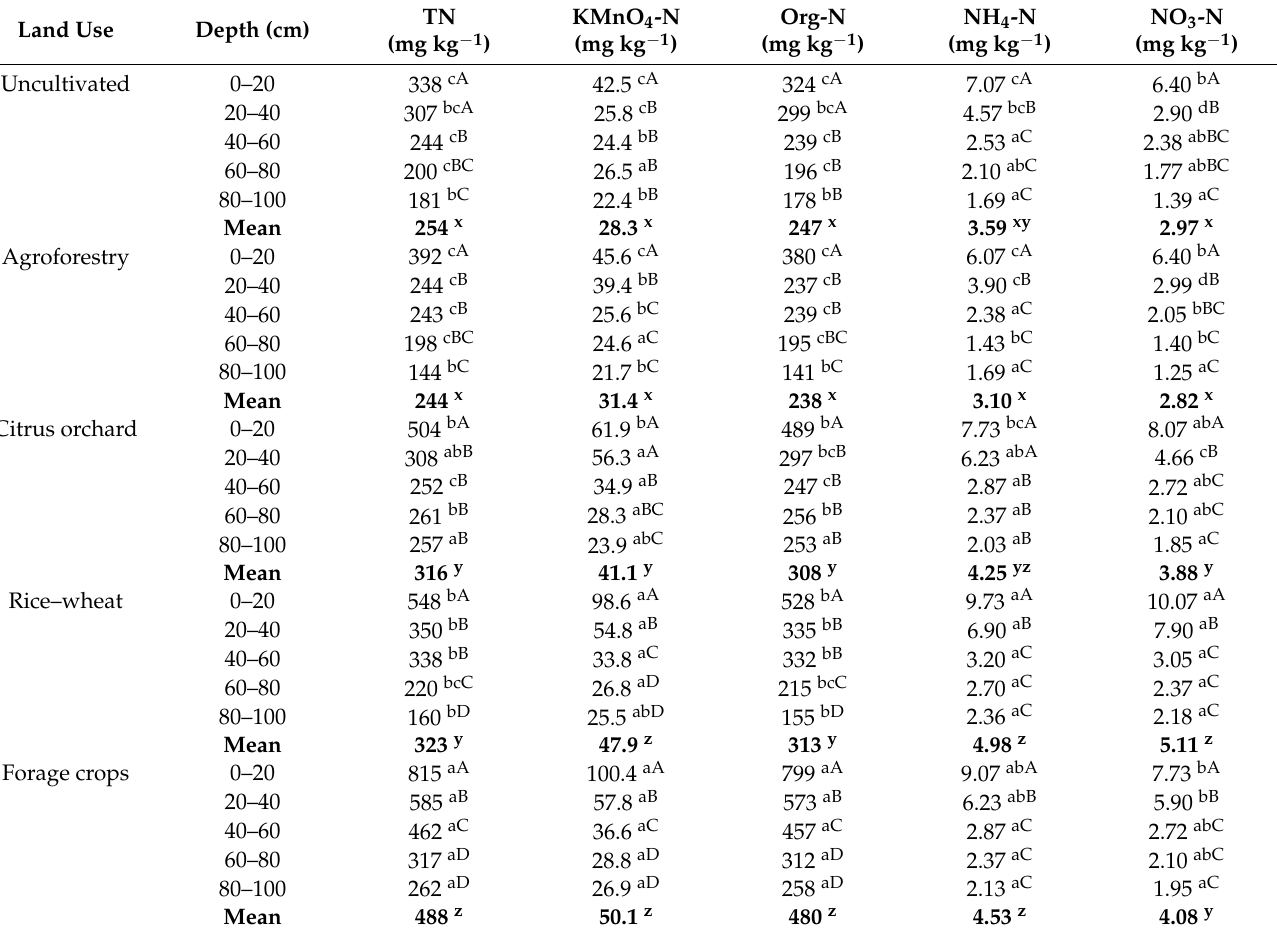
Table 5. Depth-wise distribution of total N and its fractions as impacted by different land use